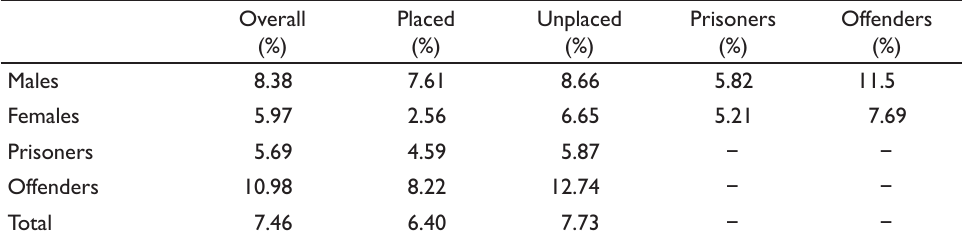
Table 2: Re-offending rates of programme participants